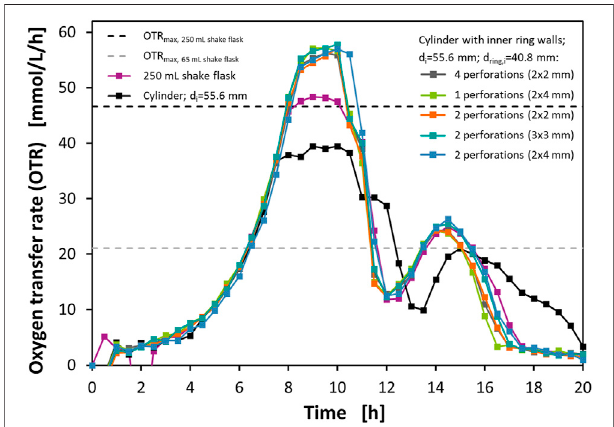
FIGURE3| Oxygen transfer rates(OTR) from cultivations of E. coli BL21 in mineral medium in perforated ring fl asks with inner vessel diameter d i = 55.6 mm, inner ring diameter d ring,i = 40.8 mm, and wall thickness d wall = 1.6 mm. The full lines with data points show OTRs from different fl asks measured with RAMOS. The dashed horizontal lines show the predicted OTR max levels for a 250 ml shake fl ask and a theoretical 65 ml shake fl ask according to Meier et al. (2016). Experimental conditions: Wilms-MOPS medium with 23 g/L glucose; temperature T = 37 ° C; fi lling volume V L = 10 ml; shaking diameter